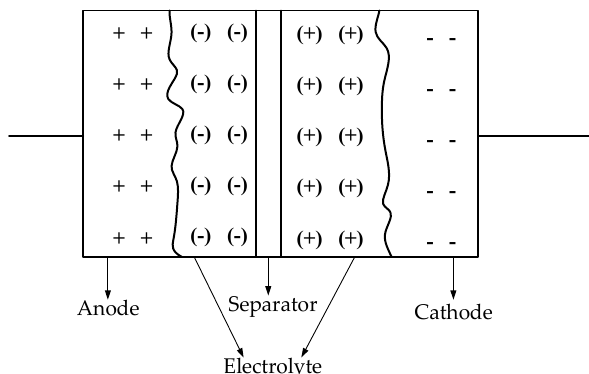
Figure 1. Basic structure of double layer capacitors (DLCs) showing the four main components of its construction.